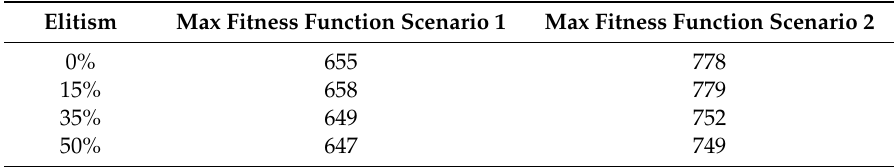
Table 3. Maximum fitness function representation for the best selection operator (Tournament 3) in terms of elitism percentage during population reproduction.